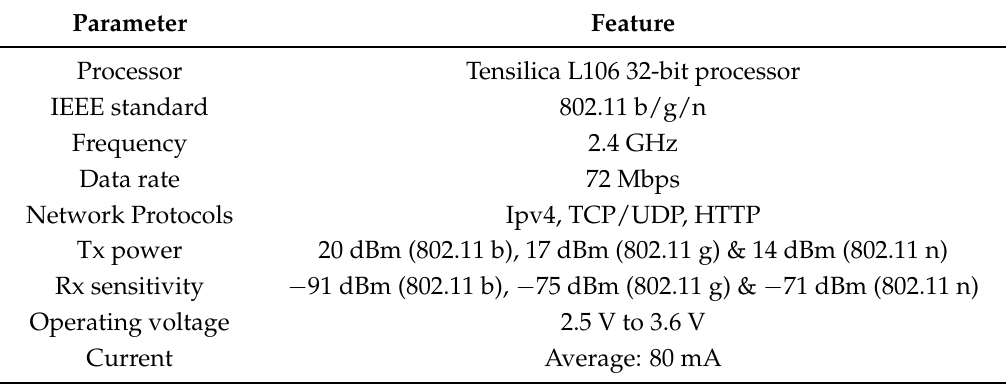
Table 3. Technical specifications of ESP 8266